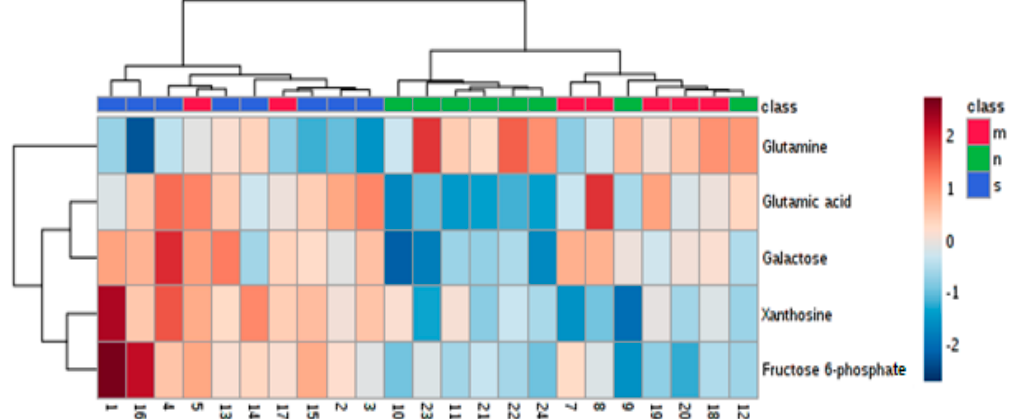
Figure 5. Heatmap for the overview: in both analyses, two separated groups of samples are distinguished, i.e., blue—rats on a standard diet and green—group treated with Zn nanoparticles (NP); inclusions of samples from the third group are observed—labeled in red—group treated with zinc microparticles.